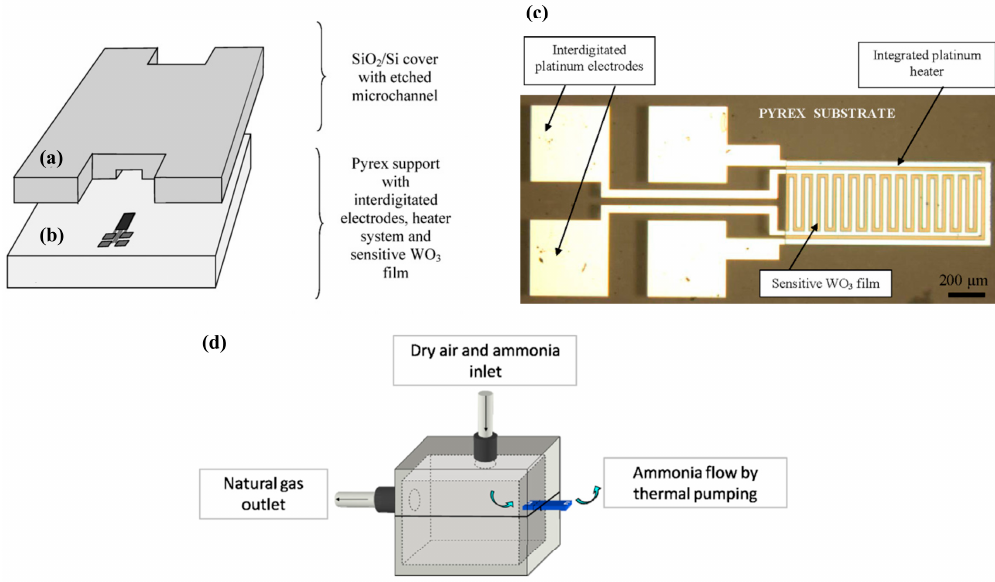
Figure 4. Microsensor and device assembly. ( a ) Silicon wafer with etched microchannel, and ( b ) Pyrex wafer with the integrated sensor. ( c ) The microsensor with interdigitated platinum electrodes, gas sensing film and platinum heater. ( d ) Detection chamber. Reproduced with permission from [46,47]. Copyright 2012, Elsevier.